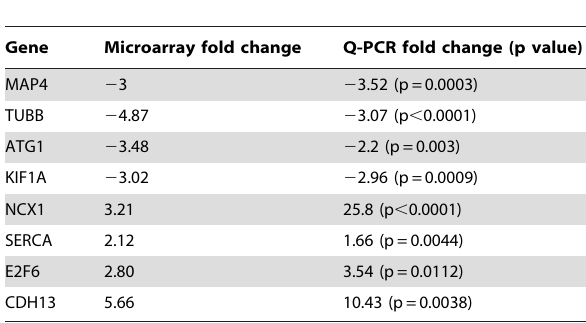
Table 5. Comparison of fold-changes calculated by microarray experiments and determined by Q-PCR.